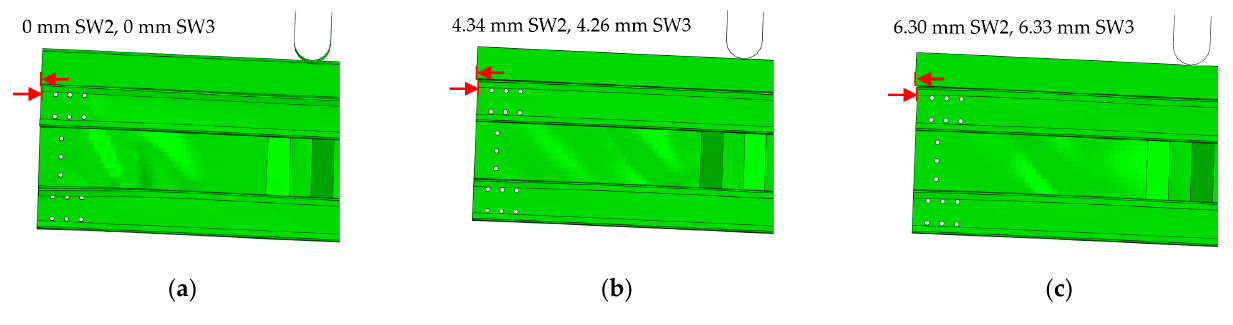
Figure 16. Differences in end slip between three analysed solutions of pinned beam: ( a ) full tie shear connection; ( b ) shear connectors spaced at 300 mm; ( c ) shear connectors spaced at 600 mm.